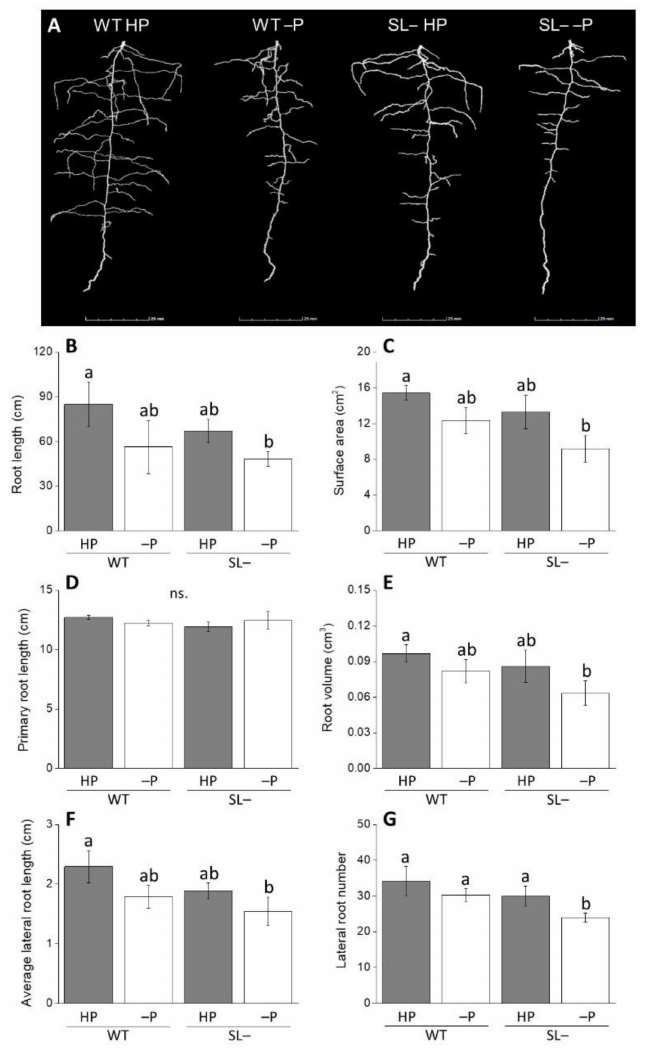
Figure 2. ( A ) Image of root architecture displayed by X-ray CT; ( B – G ) Root growth-associated parameters of wild-type (WT) and strigolactone-depleted plants (SL–) grown for 10 days inside columns filled with quartz sand and daily watered with modified Hoagland solution containing either high P (HP) or no P (–P). Data represent the means of measurements on 3 independent replicates per genotype and condition ( ± SE) obtained via X-ray CT. Di ff erent letters above bars indicate significant di ff erences between treatments ( p ≤